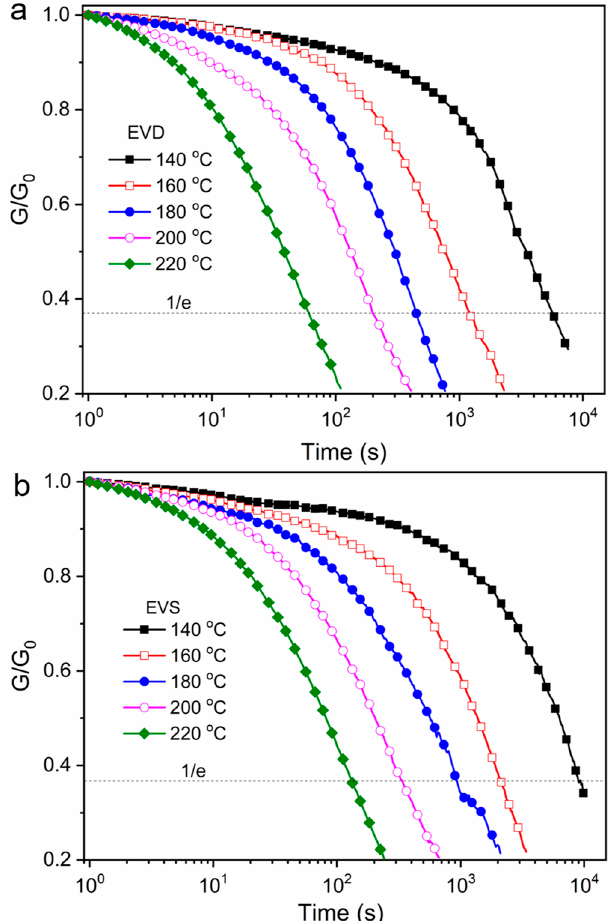
Materials 2021 , 14 , x Figure 6. Stress-relaxation curves of ( a ) EVD and ( b ) EVS at different relaxation temperatures.